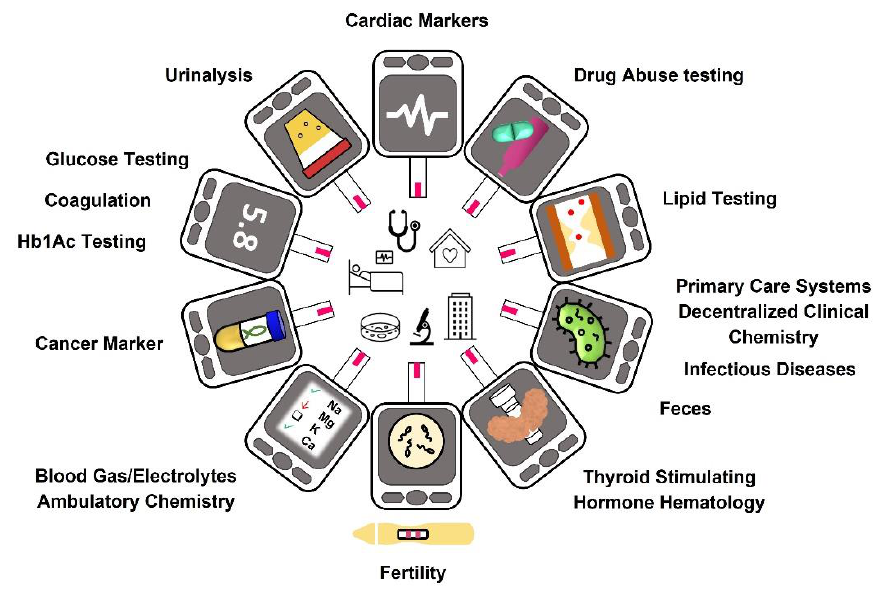
Figure 3. PoC Diagnostics Market and its segmentation attending to the target analysis and end-use: The market is classified in 14 different products according to pathology diagnostic, and in five kinds of products attending to the end use. (Data extracted from Grand View Research´s report [29]).